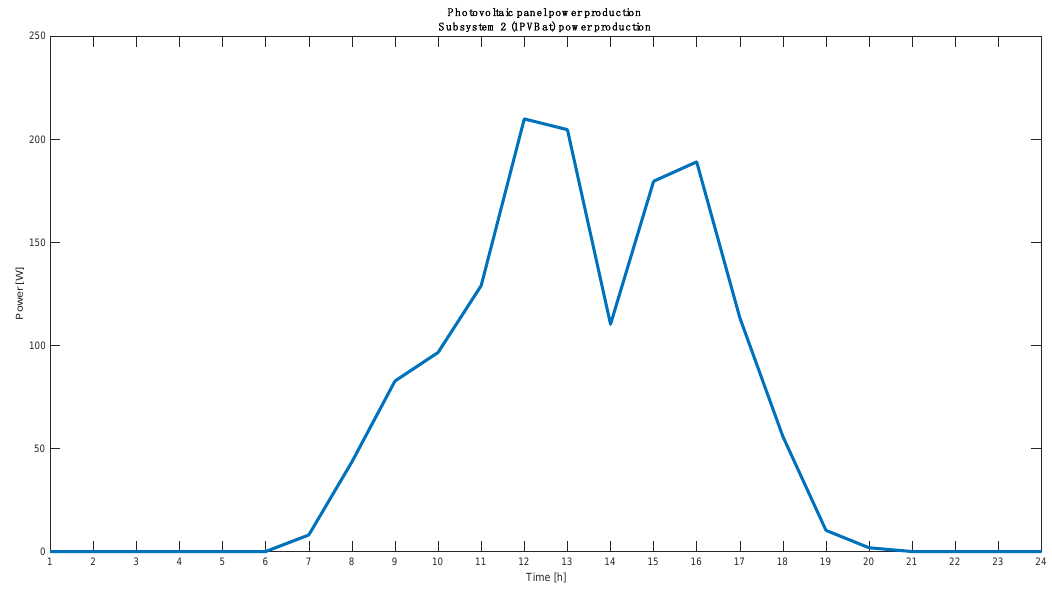
Figure 12. Subsystem 2: 1 PV generation connected to a battery bank.